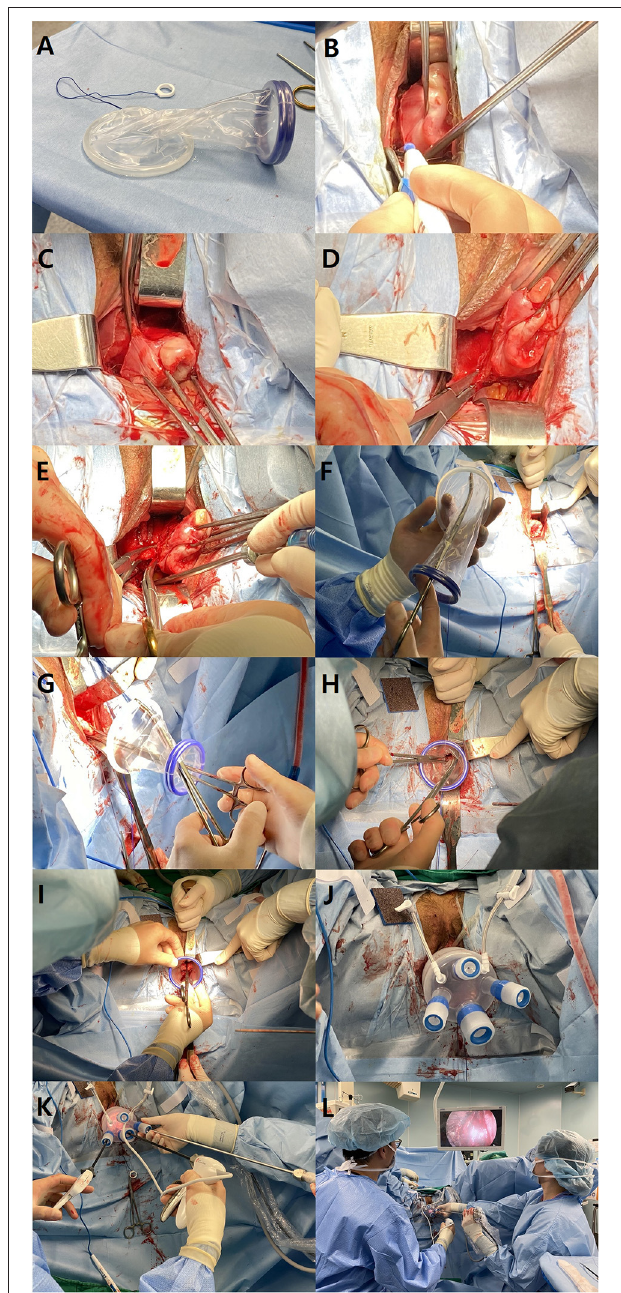
FIGURE 1 | Procedures of vNOTES. (A) The wound retractor consists of two elastic rings with different diameters (6 and 9cm). The larger ring is inserted and hooked at the vesicovaginal space and posterior cul-de-sac. (B) The anterior and posterior lips of the cervix are grasped together with two tenaculum forceps. A circumferential incision is made at the junction of the vagina and cervix. (C) The right bladder pillar is coagulated and cut with a monopolar Bovie electrocauterization. (D) The right uterosacral ligament is ligated with a suture ligature. (E) Following the right lateral wall of the uterus cephalad, the uterine artery is ligated with a suture ligature along with the cardinal ligament. (F) The larger ring of the wound retractor is grasped with a curved Kelly to facilitate the insertion into the peritoneum. The Kelly forceps are (Continued)